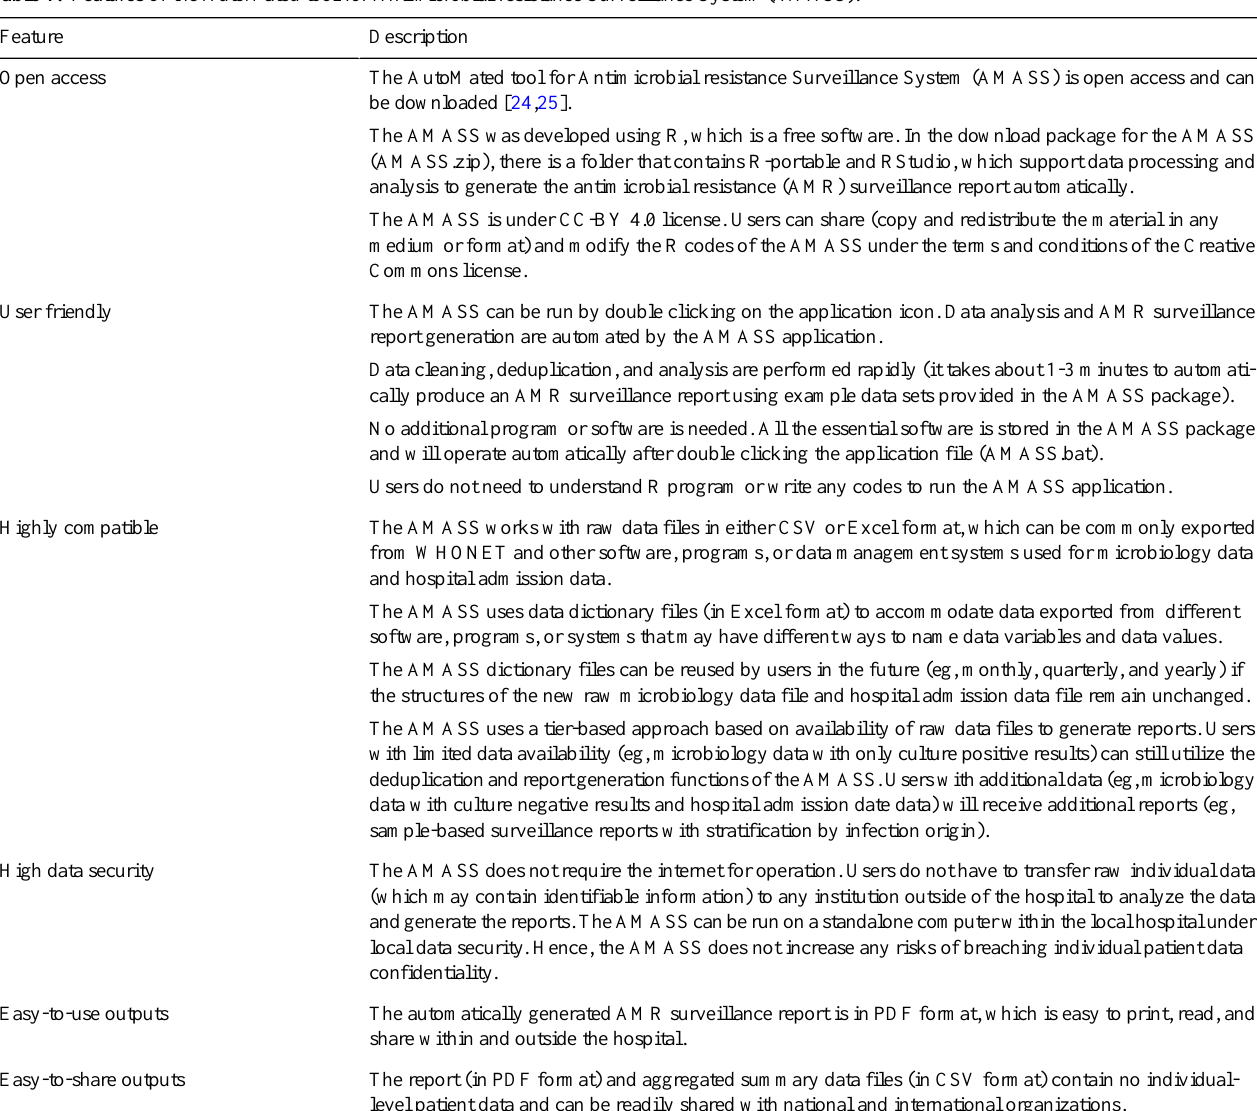
Table 1. Features of the AutoMated tool for Antimicrobial resistance Surveillance System